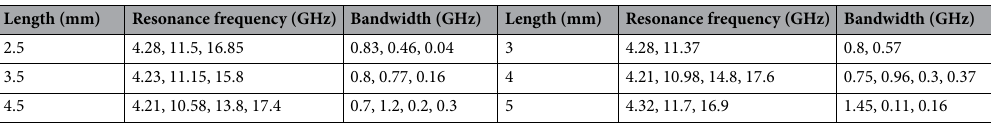
Table 3. Performance comparison of the MTM for different stub lengths in terms of resonance frequency and bandwidth.